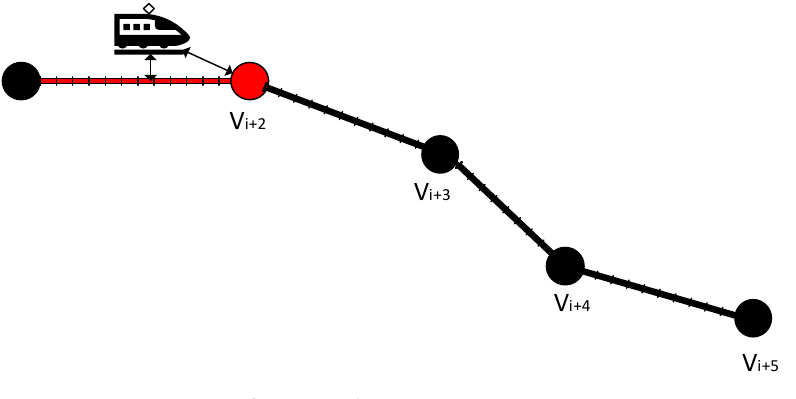
Figure 12. Basic concept of position detection.